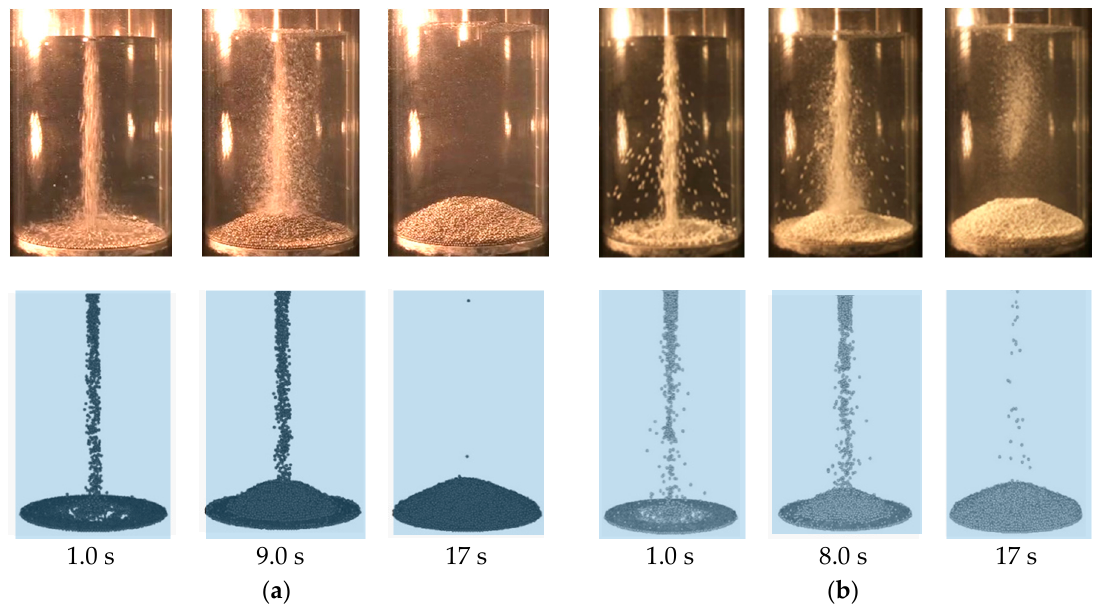
Figure 3. Falling and sedimentation behavior of homogeneous particles with d p = 6 mm: ( a ) Case 1; ( b ) Case 2.